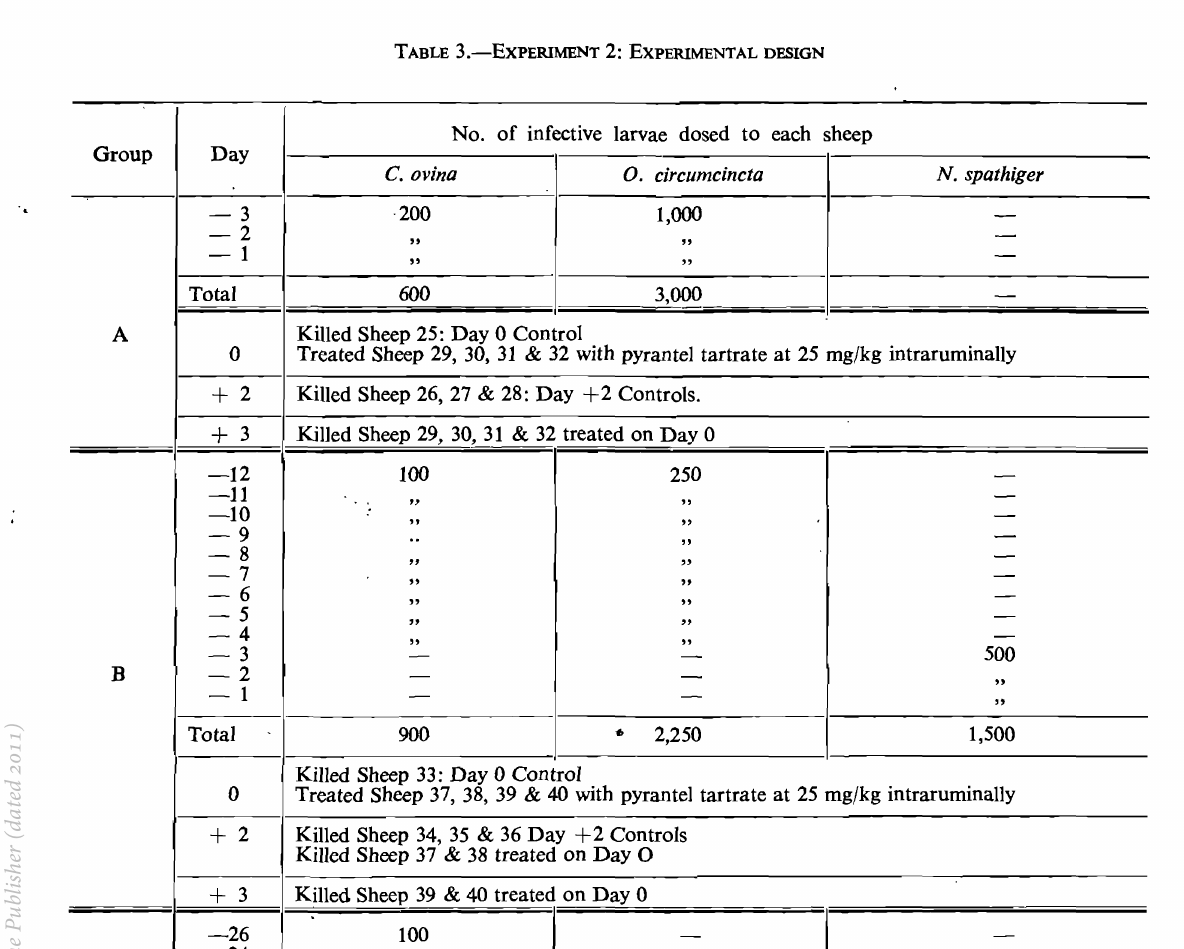
TABLE 3.-ExPERIMENT 2: EXPERIMENTAL